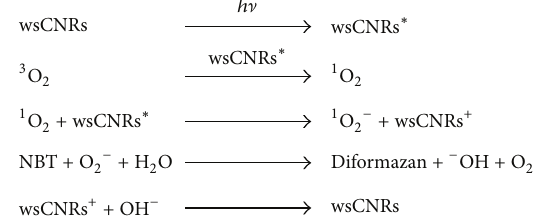
Scheme 1: A schematic illustration for the generation of reactive oxygen species and hence reduction of NBT induced by visible